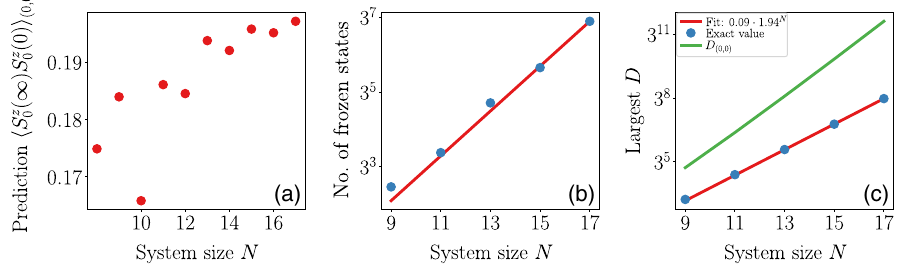
R T dt h S z t Þ S z 0 Þi 0 ð 0 ð 0 ð 0 ; 0 Þ